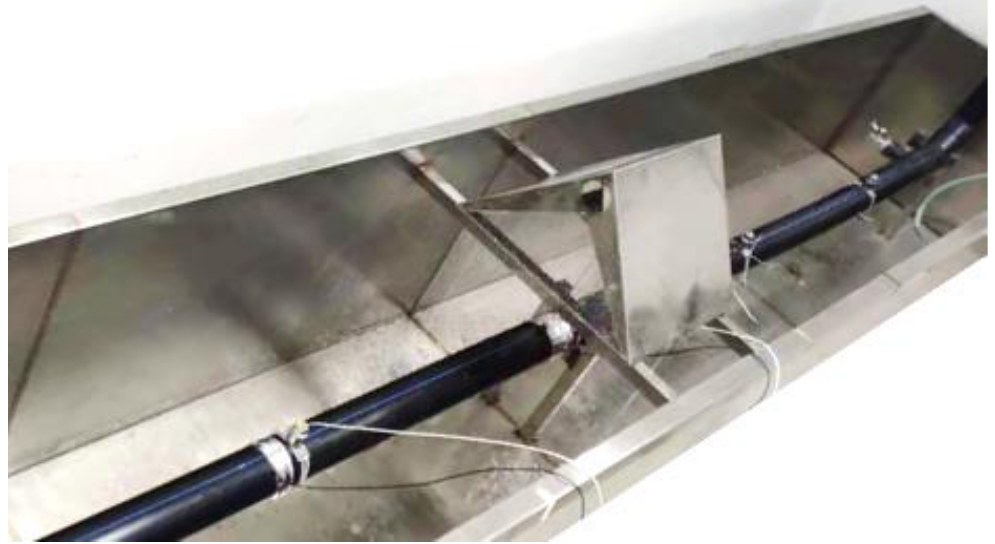
Figure 9. Experimental setup of the PE water pipe.